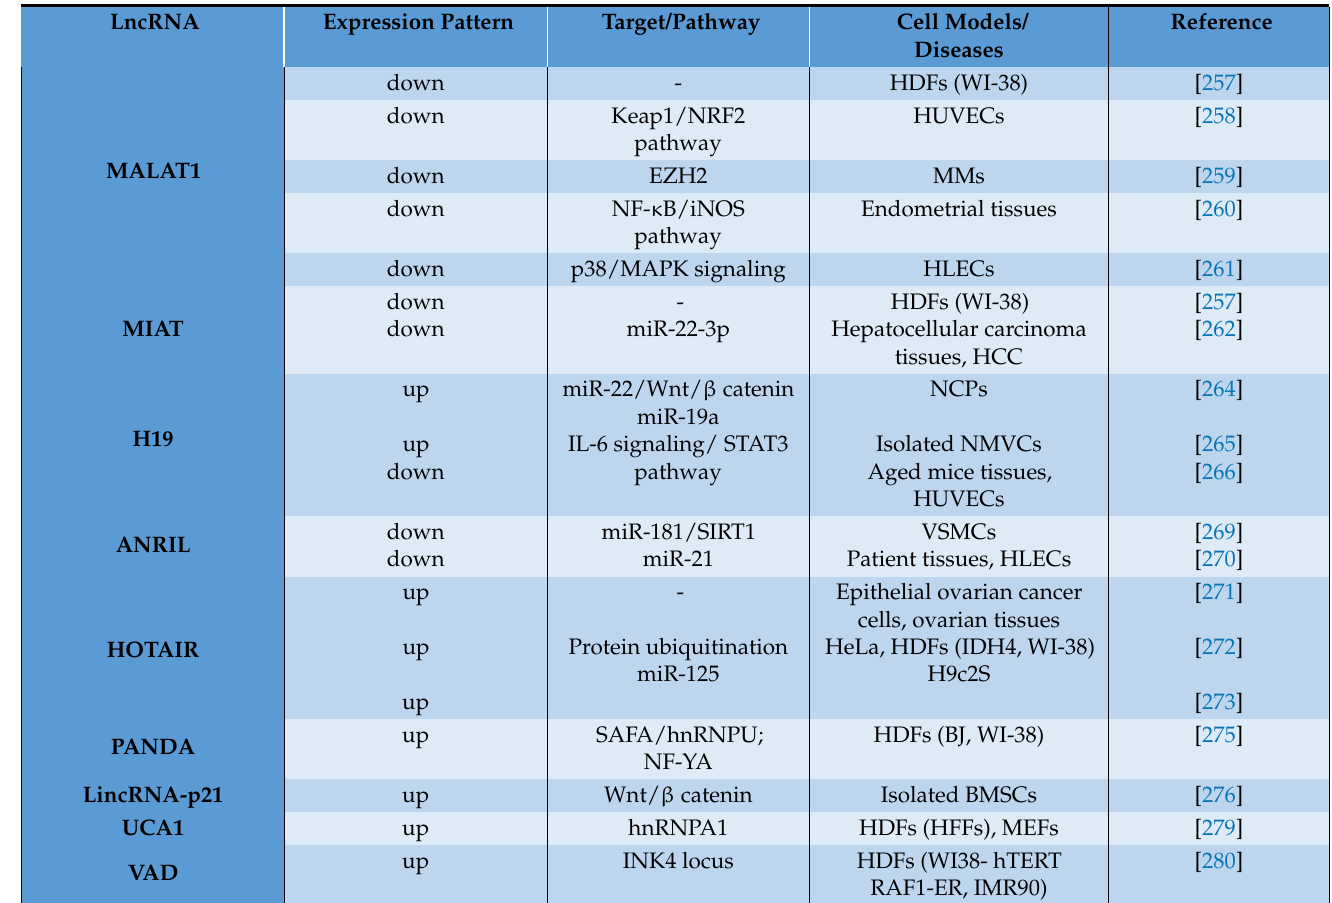
Table 2. List of lncRNAs whose expression and targets/pathways are implicated in oxidative stress- induced